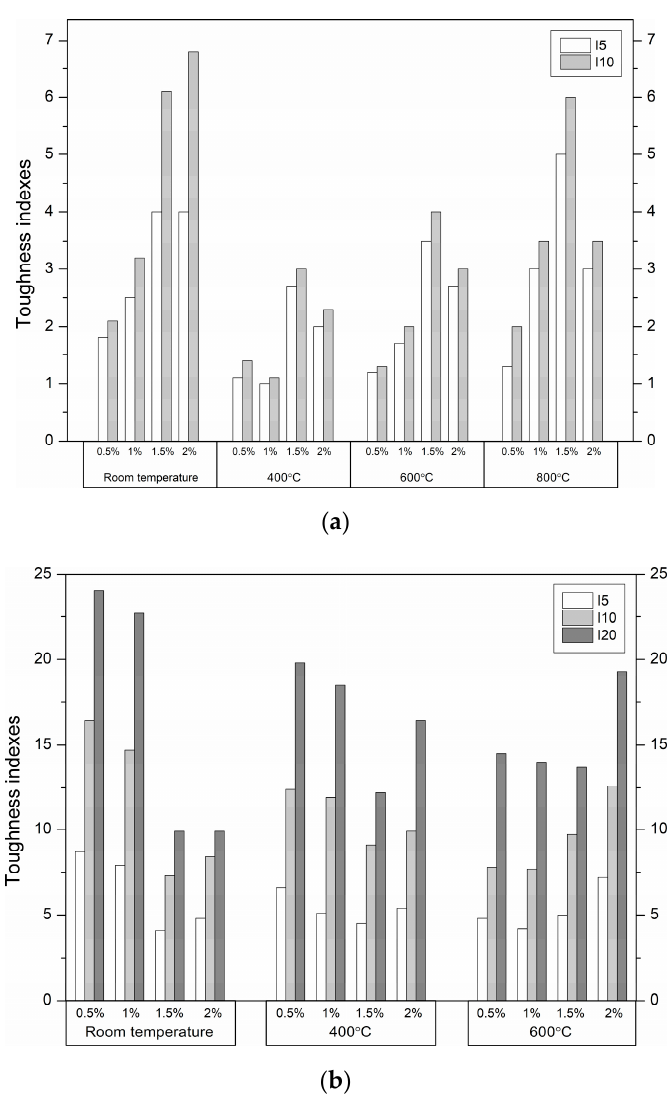
Figure 7. Toughness indexes of ( a ) polypropylene fibre (PPF)- and ( b ) steel fibre (SF)-reinforced UHPC.